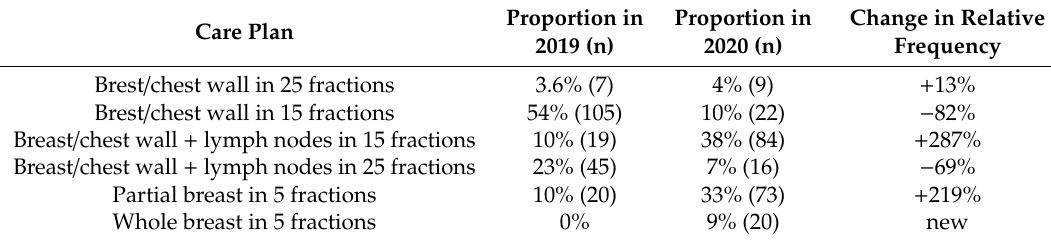
Table 3. Breast cancer